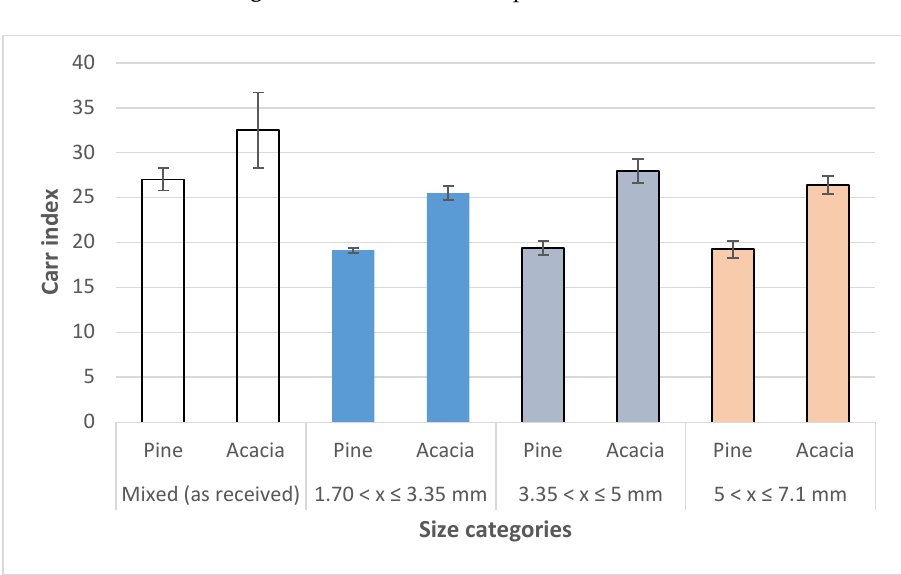
Figure 8. Carr indices for pine and acacia.